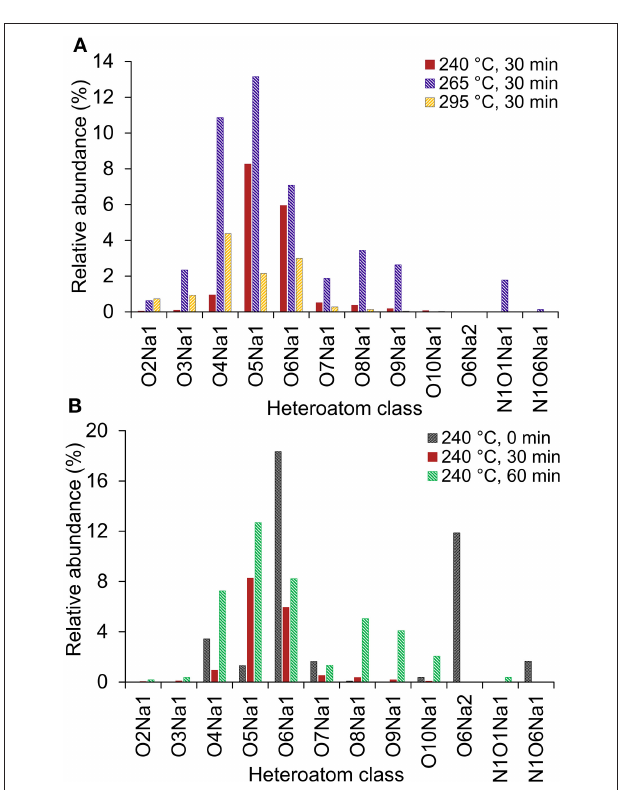
FIGURE 5 | (A) Effect of HTL temperature and (B) reaction time on Na-containing heteroatom class distribution on bio-crude oil from HTL of food waste derived from positive-ion Electrospray ionization (ESI) Fourier transform ion cyclotron resonance mass spectroscopy (FT-ICR